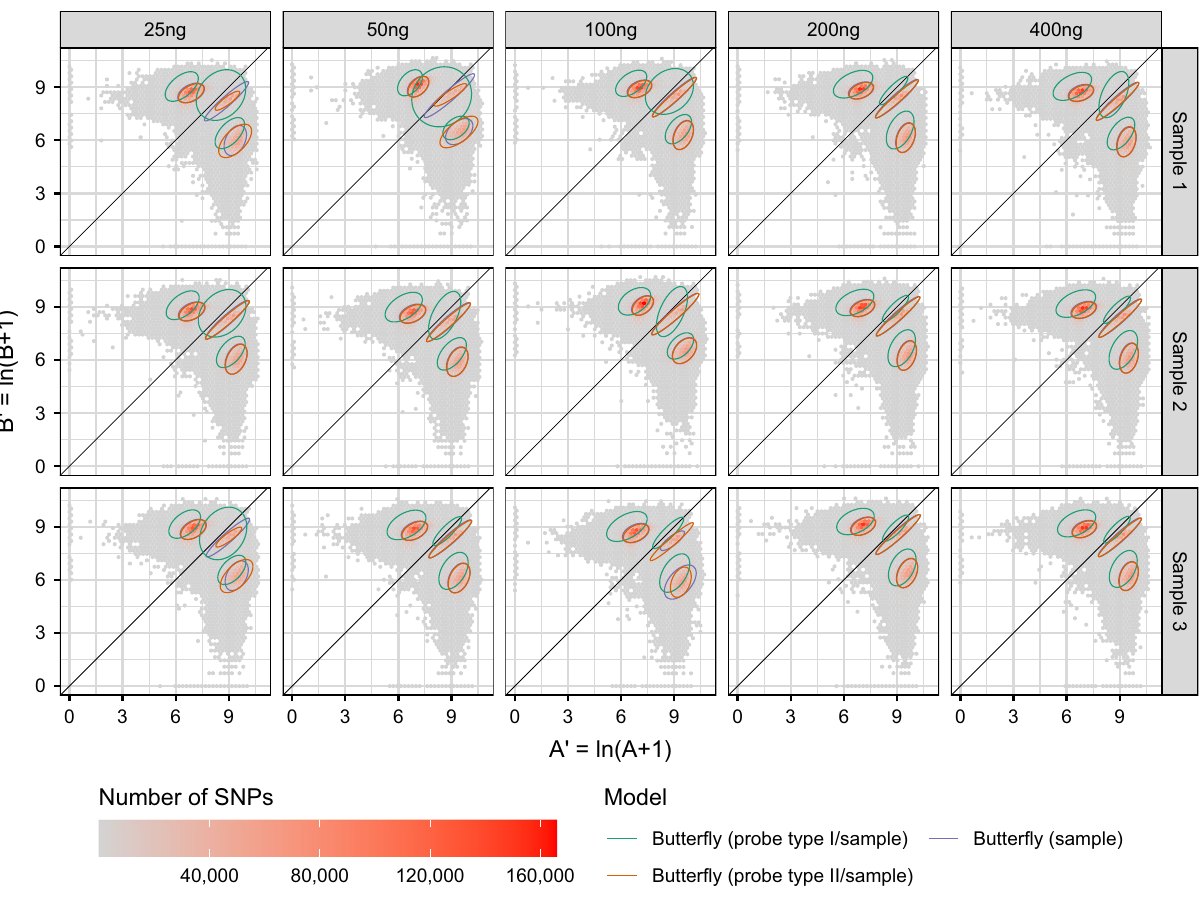
Figure 2. The mean signal intensities for alleles A and B. The three SNP groups AA, AB, and BB (in A/B nomenclature) form butterfly patterns. The 75% confidence ellipses of the three models were plotted on top of the transformed signal intensities. Note that the two models “Butterfly (probe type I/sample)” and “Butterfly (probe type II/sample)” together give “Butterfly (probe type/sample)”, which is used as a separate method below. The SNP groups (genotypes) are well-separated in most cases.